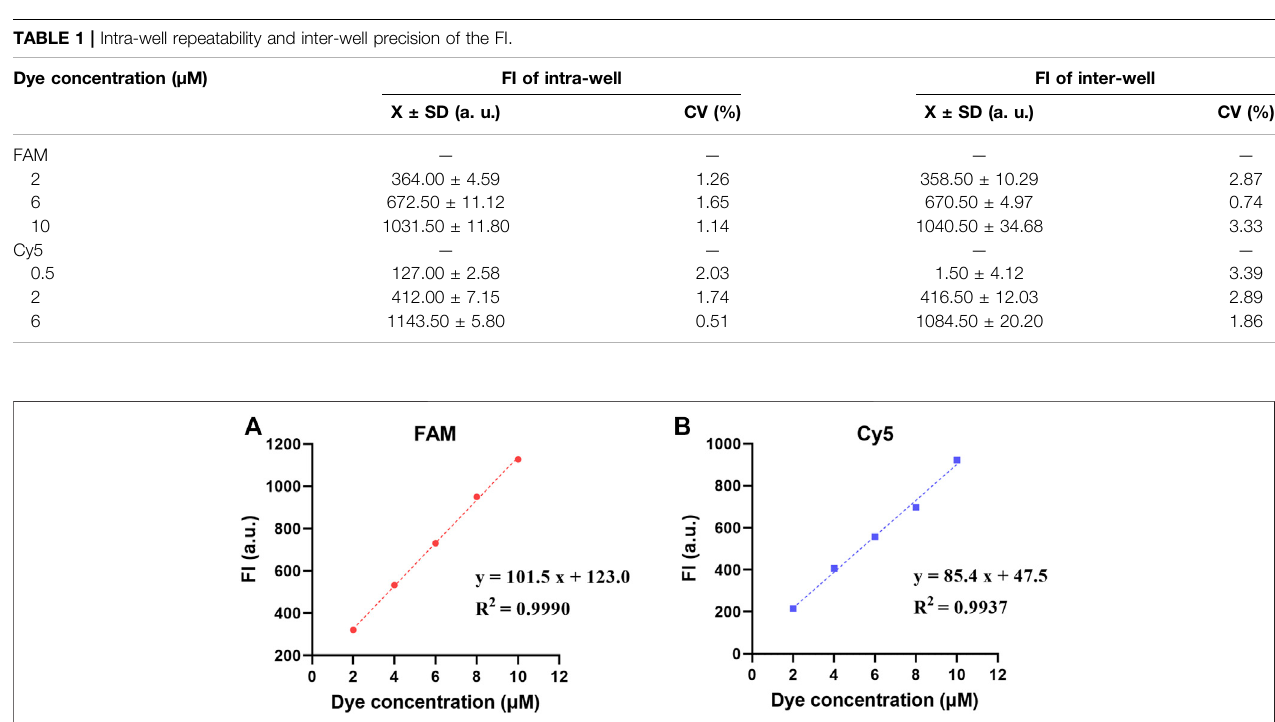
FIGURE 4 | Fluorescence linear analysis in two fl uorescence channels: (A) the FI of FAM channel; (B) the FI of Cy5 channel.